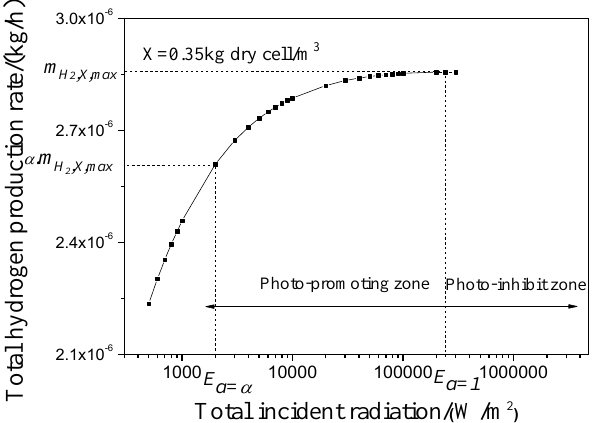
Figure 3. Photo-promoting and photo-inhibit zone.